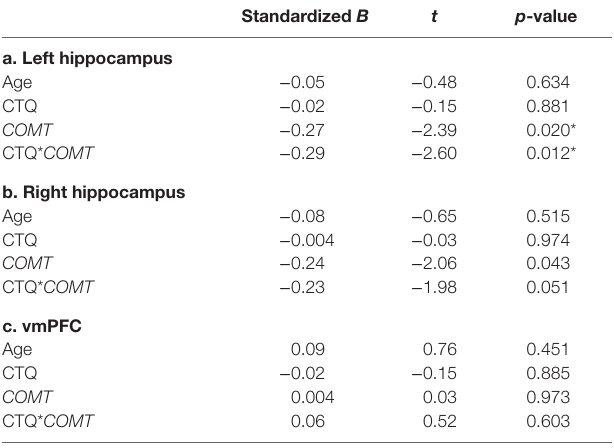
TaBle 2 | results of moderated regression analyses.